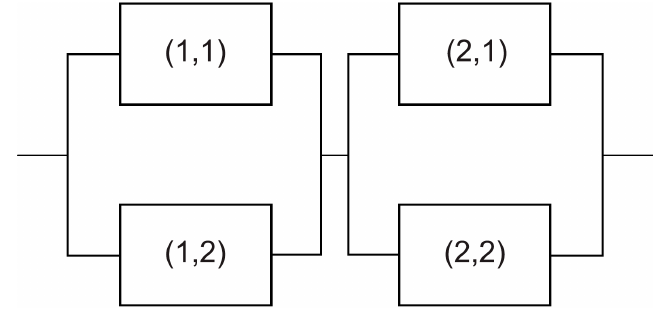
Figure 6. Series-parallel system. Table 2. System parameters and maintenance characteristics.